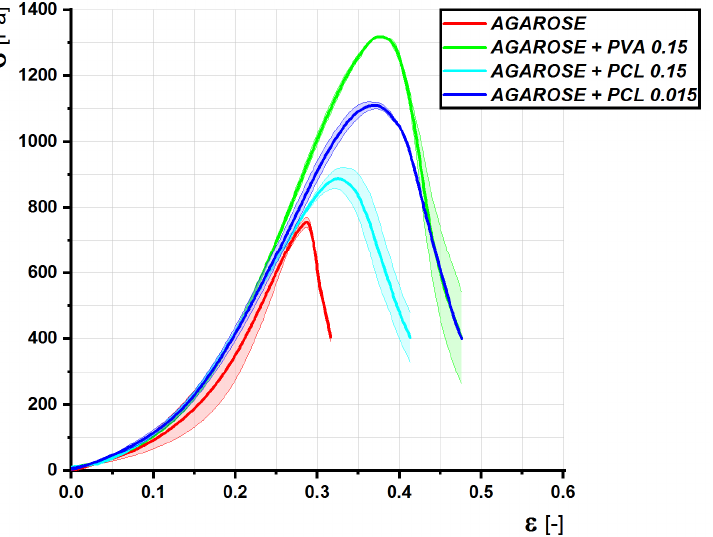
Figure 5. Dependence of the internal stress on the relative deformation under the loading of the gel by simple pressure. The thick line indicates the average of the measurements, the field standard deviation. The samples were compressed at a rate of 0.5 mm/s.